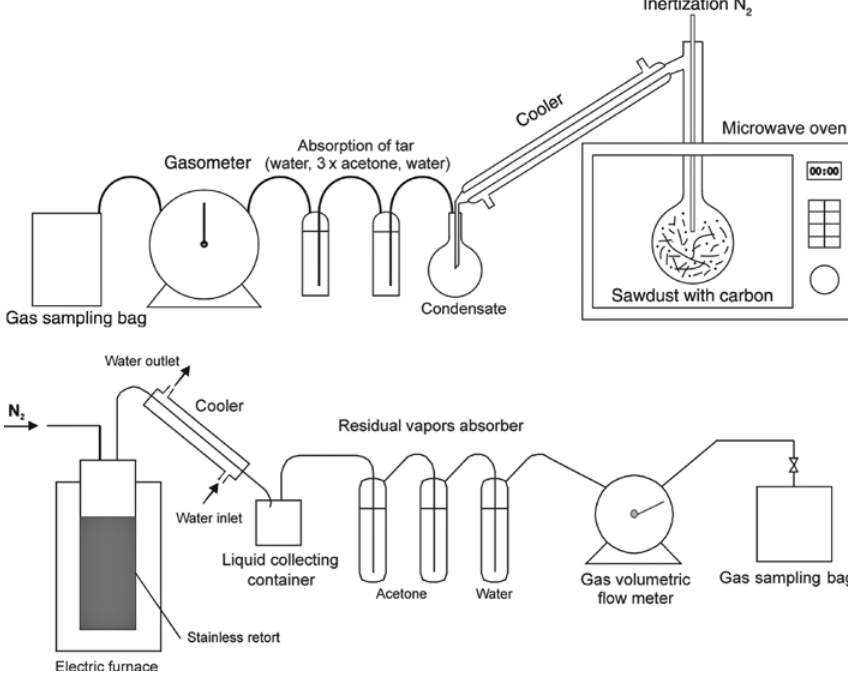
Figure 1: Microwave and conventional